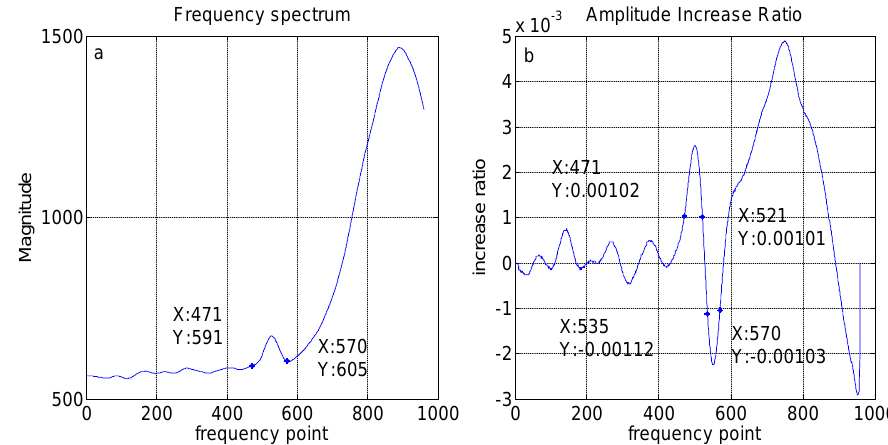
Figure 8. ( a ) Frequency spectrum at gate 12 with the background; and ( b ) frequency spectrum at gate 12 without the background.